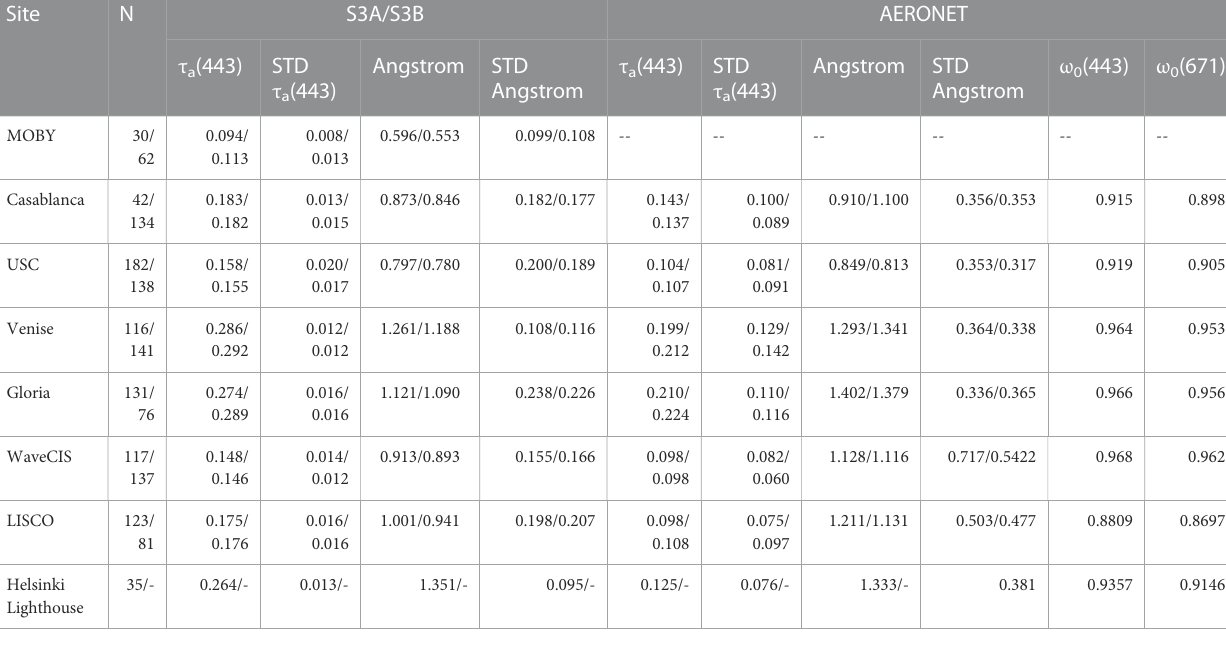
TABLE 2 Average atmospheric parameters at the sites of study determined from satellite and AERONET retrievals.